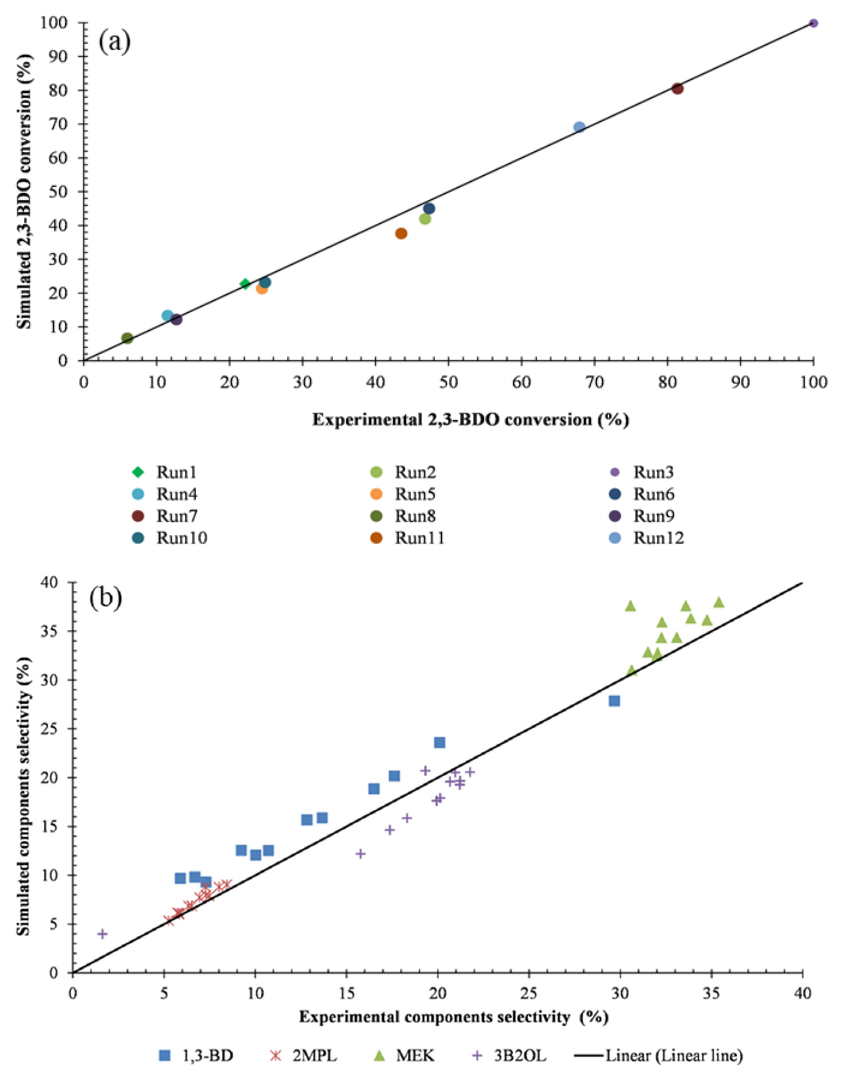
Figure 7. ( a ) 2,3-BDO conversion, ( b ) The selectivity of major components. (Run x: Experimental test x).